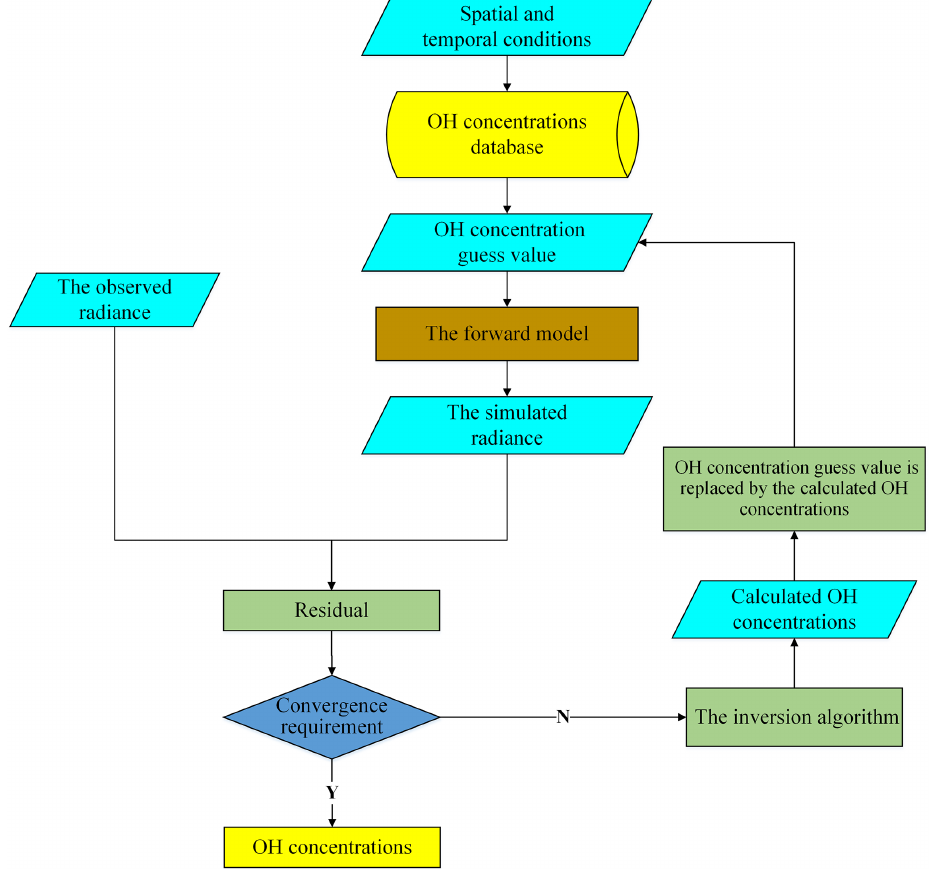
Figure 18. Schematic diagram of iterative